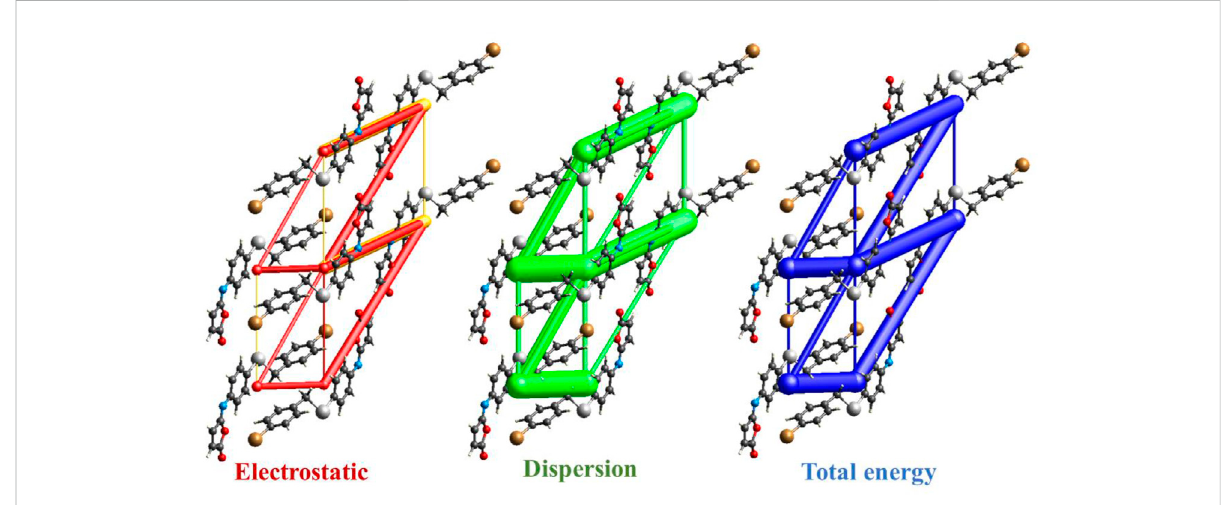
FIGURE 8 Energy-frameworkdiagramsofisomaleimide 4 alongthe a axis:Electrostaticinteractionenergies(red);dispersioninteractionenergies (green); total interaction energies (blue).